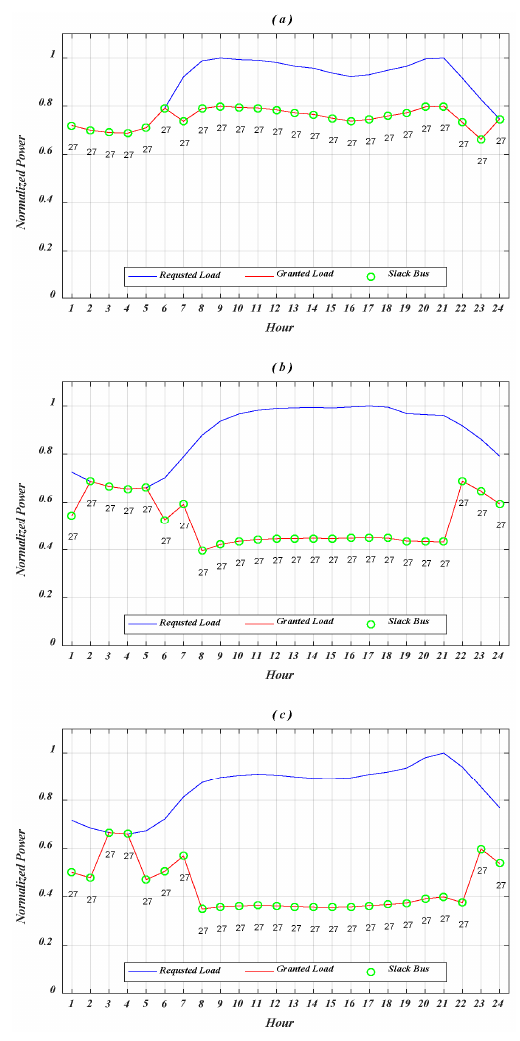
Figure 5. Normalized requested demand, and the power granted for 24 h when MGs located at L2 for: ( a ) Area 1; ( b ) Area 2; and ( c ) Area 3.